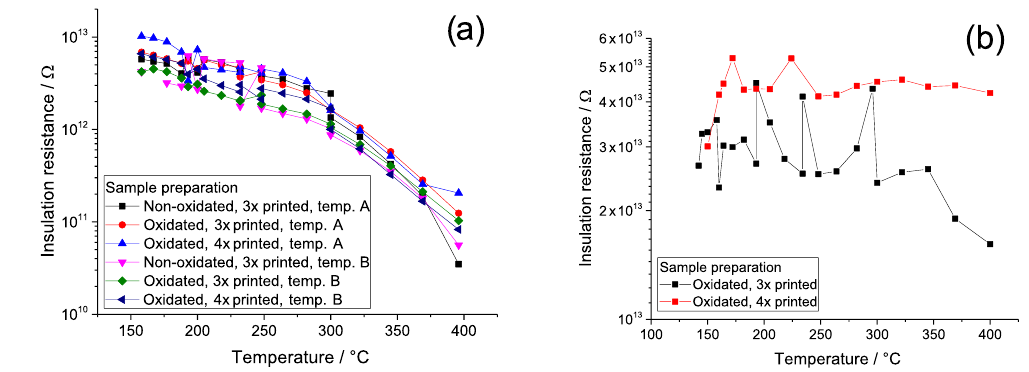
Figure 8. (a) Insulation resistance of glass insulation of steel substrate and (b) insulation resistance of IKTS glass composition on steel 1.4828.